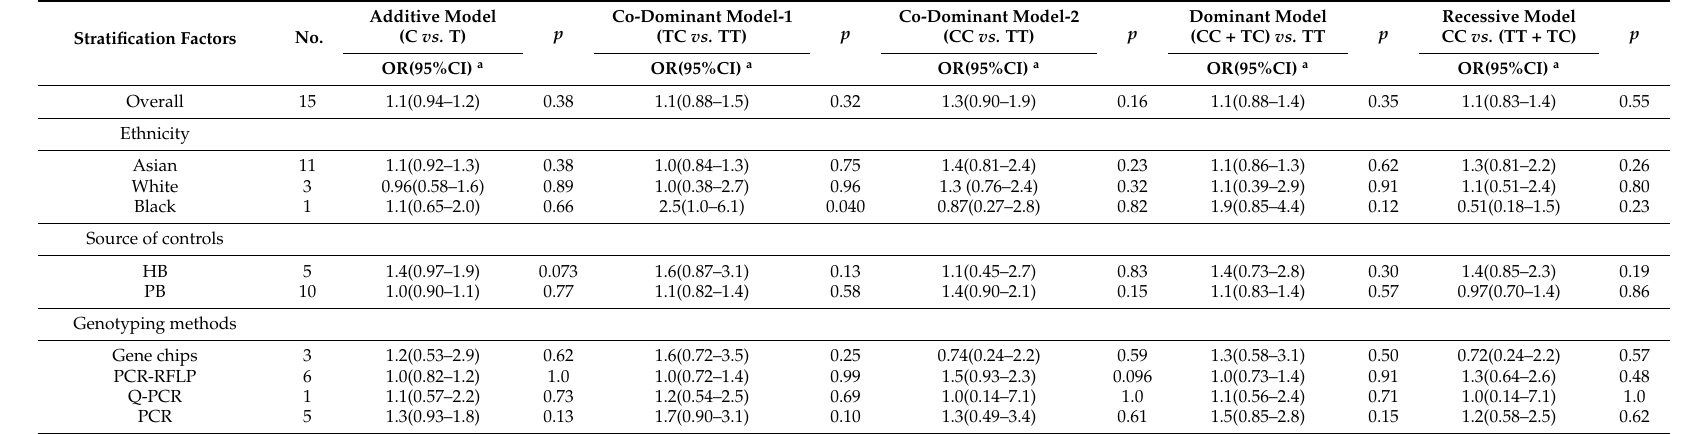
Table 3. Meta-analysis of T2238C polymorphism and EH.